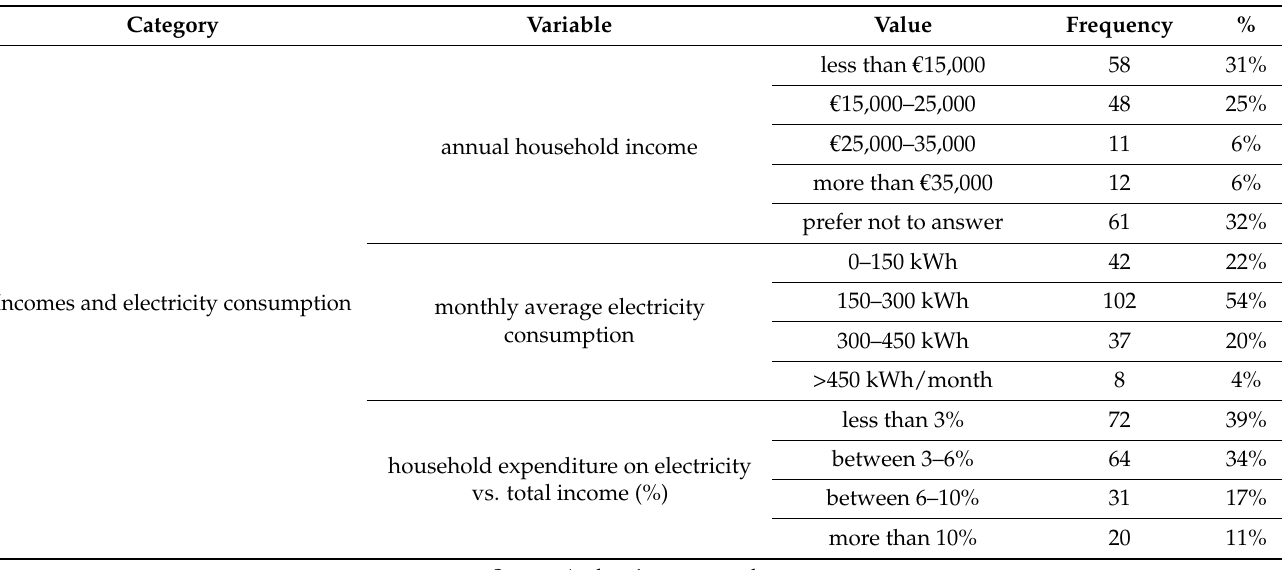
Table 3. Consumers’ incomes and electricity